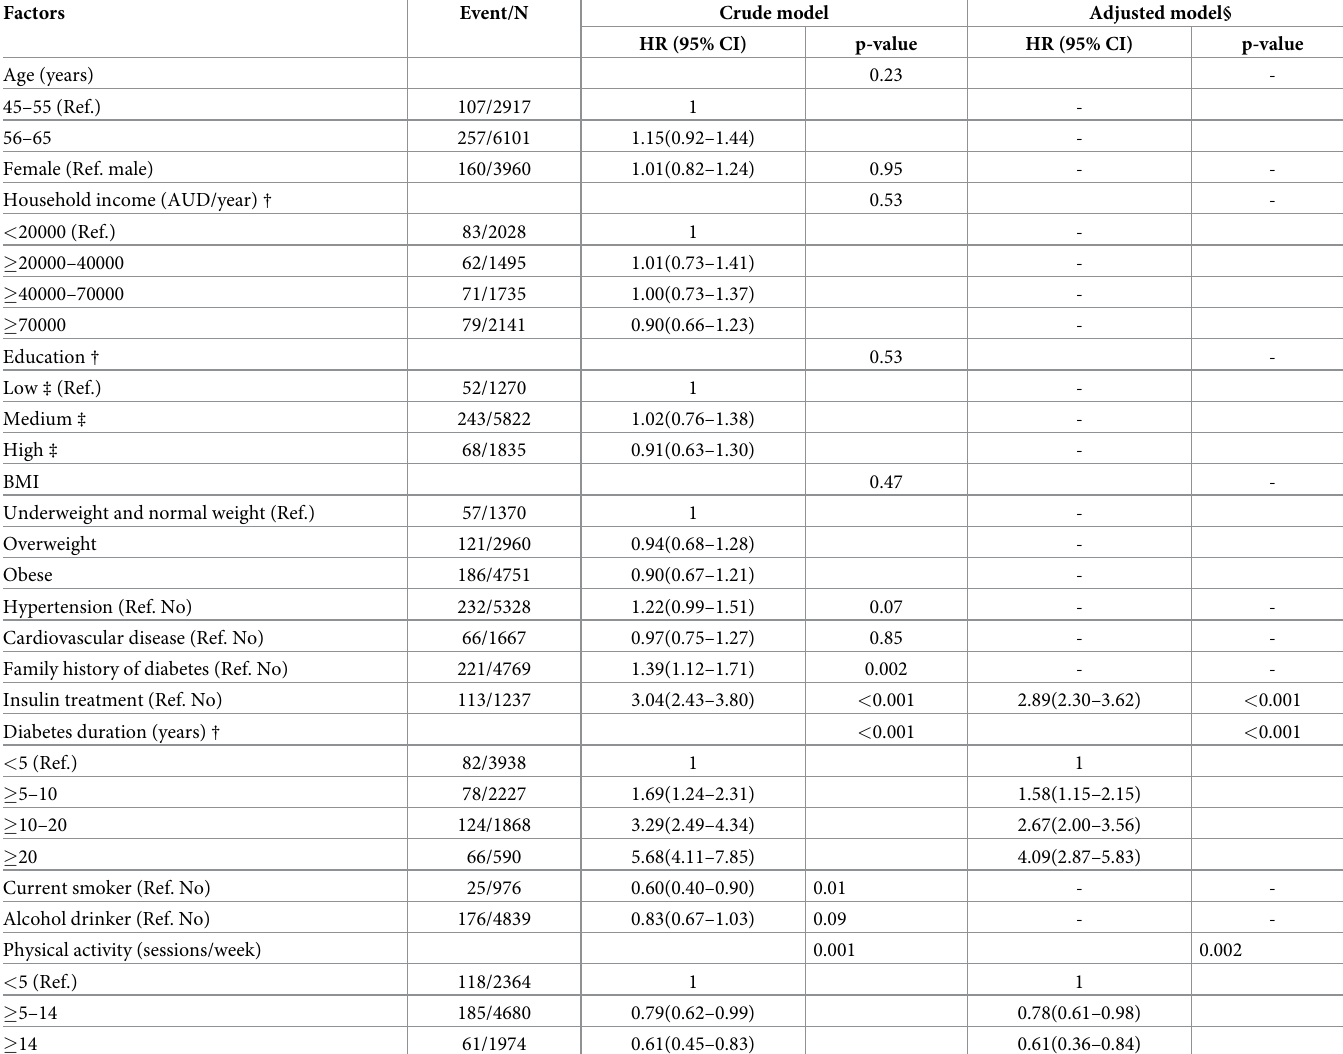
Table 2. Cox regression analysis of risk factors for RPC in diabetic